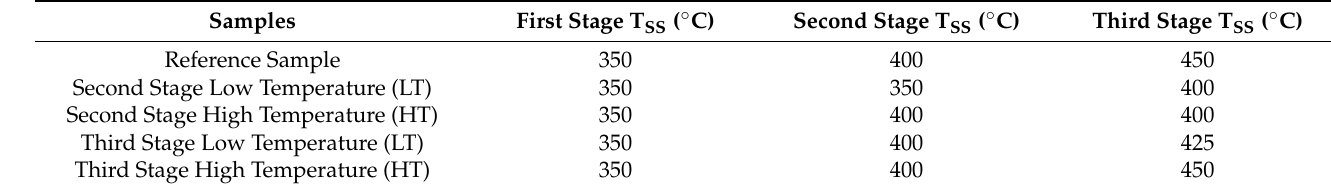
Table 1. Substrate temperature for the different stages of the CIGS